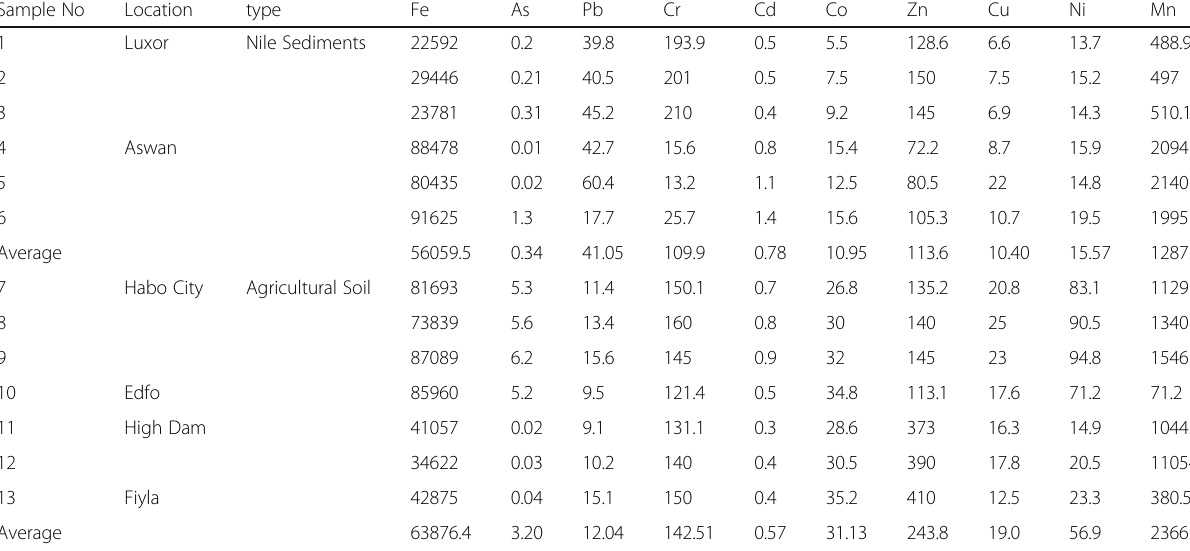
Table 1 Concentration of the heavy metals (ppm) for the studied